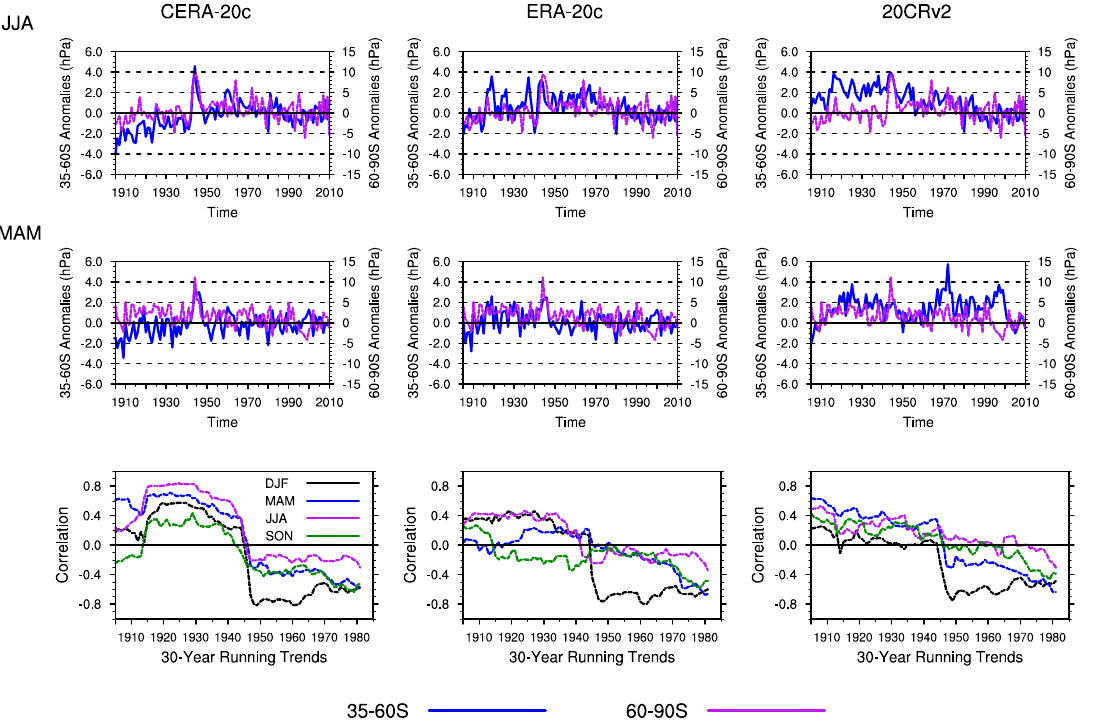
Figure 6. Top rows—Seasonal (JJA and MAM) area-averaged (35–60 ° S, left axis and 60–90 ° S, right axis) pressure anomalies relative to 1905–2010. Note the different scales on the y-axes for the respective areas. Third row—30-year running pressure correlation between the two regions, by season. Relationships are based on the 20th century reanalysis products—CERA-20C (left column), ERA-20C (middle column) and 20CR (right column).